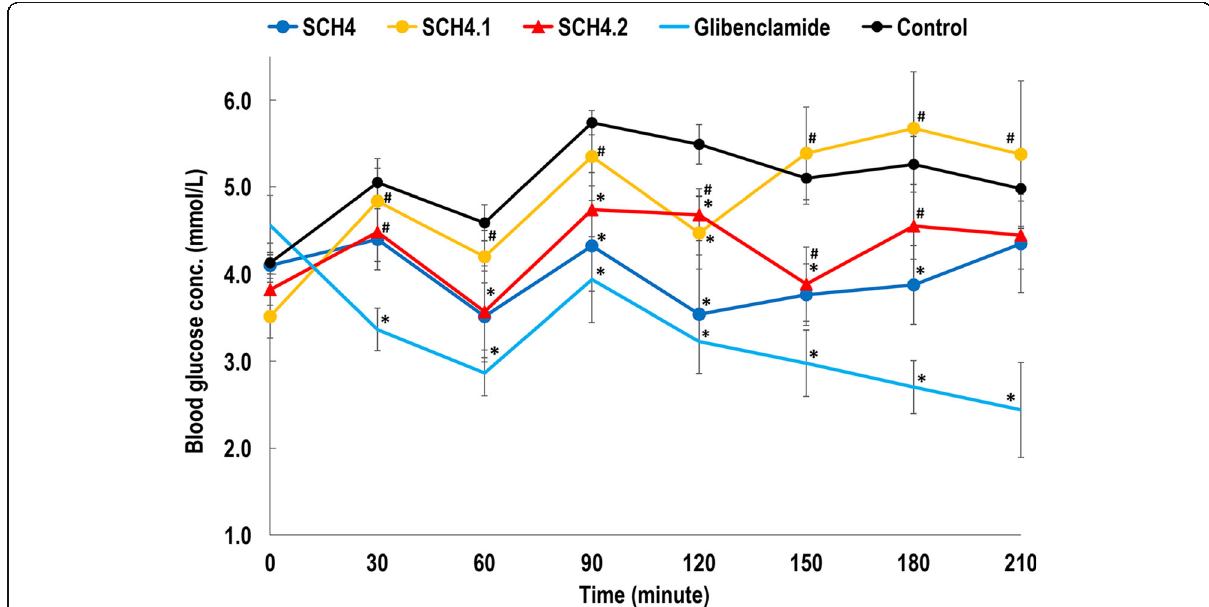
Fig. 3 Effect of sub-fractions (10 mg/kg BW) from SCH4 and glibenclamide (5 mg/kg BW) on blood glucose concentration. Data expressed as mean ± SEM ( n = 5); * represents p < 0.05 vs control and # represent p < 0.05 vs